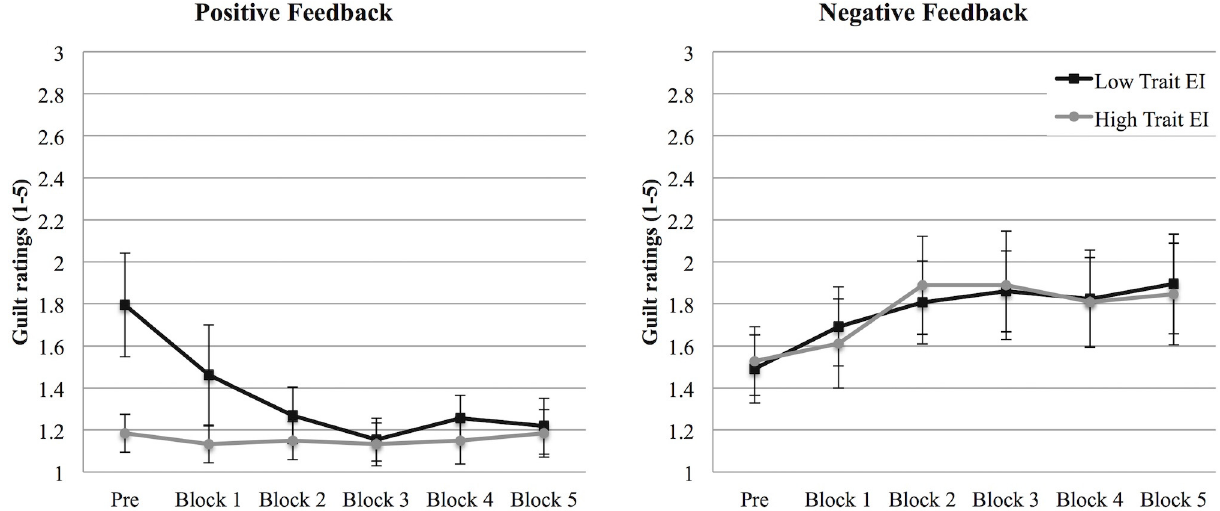
Fig 4. Guilt (Study 1). Guilt intensity at the beginning of the experiment (PRE) and after each block in the negative (left panel) and in the positive (right panel) feedback conditions for low and high trait EI participants. Error bars indicate 1 standard error above or below the